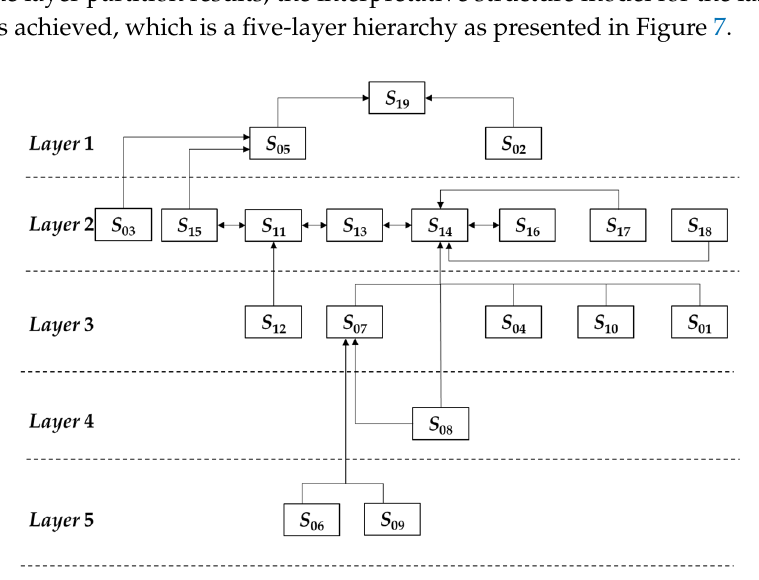
Figure 7. Interpretative structural model.